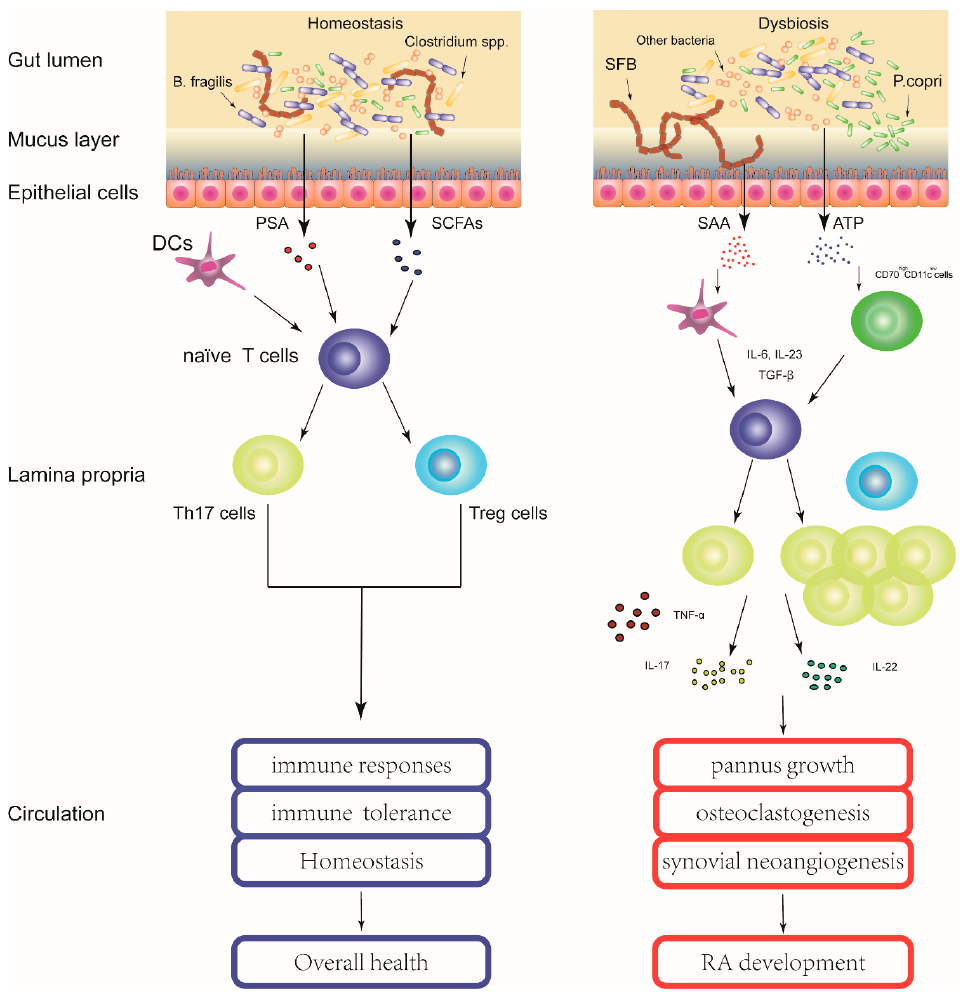
Figure 1. Gut microbiota contribute to the pathogenesis of RA. The healthy gut microbiota is in a homeostasis state that maintains integrity of the intestinal epithelial cell layer and has multiple symbiotic microbes to help in physiological functions. In genetically susceptible individuals, environmental factors can influence the gut microbiota causing changes in the types and abundance of microbiome (dysbiosis). The dysbiosis in gut microbiota, in association with genetic factors, may disrupt the innate and adaptive immune system and contribute to the development of RA via multiple molecular mechanisms. PSA, polysaccharide A; SCFAs, short-chain fatty acids; SAA, serum amyloid A; ATP, adenosine 5 ′ -triphosphate; DCs, dendritic cells; IL, Interleukin; TGF- β , Transforming growth factor-beta; Treg cells, regulatory T cells; Th17 cells, T helper 17 cells.